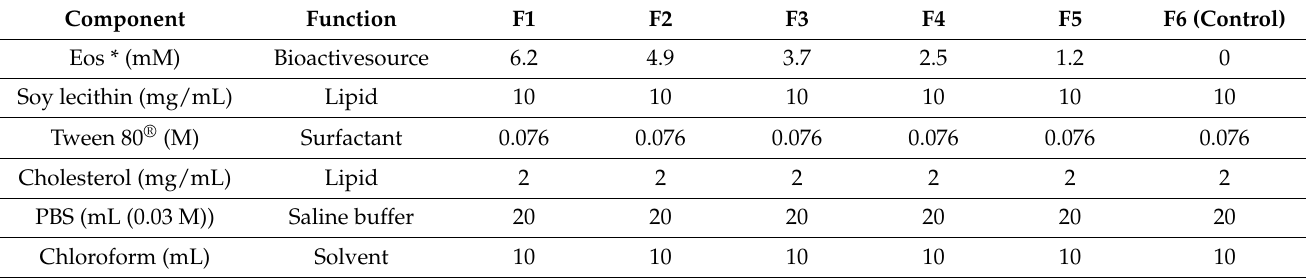
Table 6. Processing conditions and designation of freshly fabricated nanoliposome formulations (i.e., F1 to F5) of EOs (CEO/TTO), and control